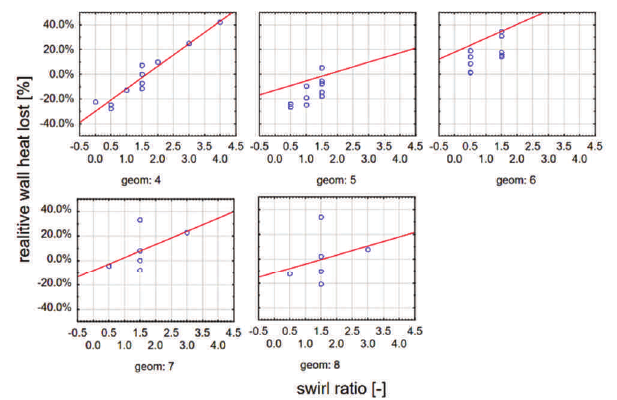
Fig. 4. Relative efficiency and swirl ratio for different